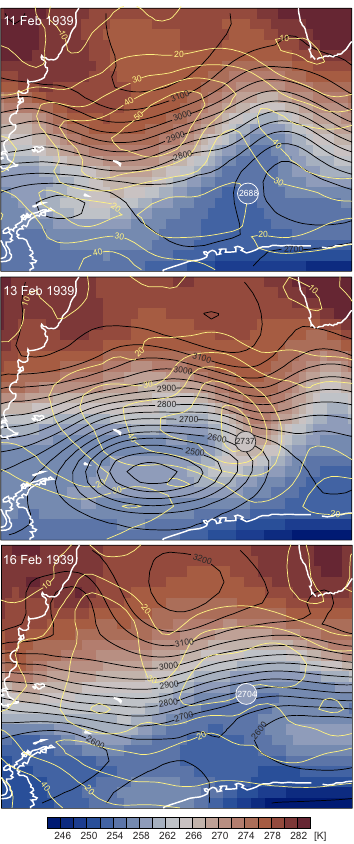
Fig. 7. GPH (solid lines) and temperature (colours) at 700hPa for three days in February 1939 (12:00UTC). The yellow lines indi- cate the ensemble spread of GPH. The large circles and numbers indicate the observed temperature and GPH, respectively. The area displayed is (70 ◦ W–30 ◦ E, 74 ◦ S–20 ◦